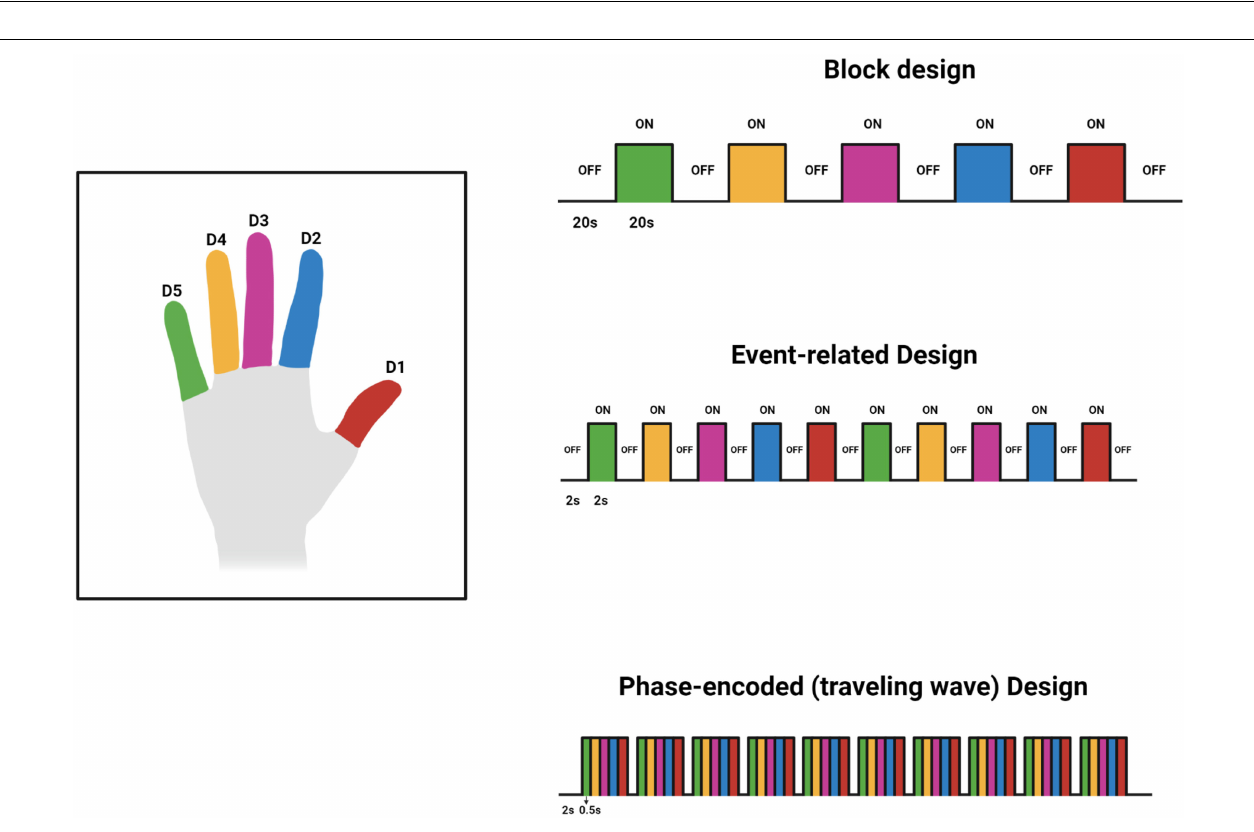
FIGURE 2 | Original work showing 3 designs used for investigating the finger somatotopy. The timings in the figure are tentative and may vary based on the investigators’ preferences and other factors. This figure was created using Biorender.com.